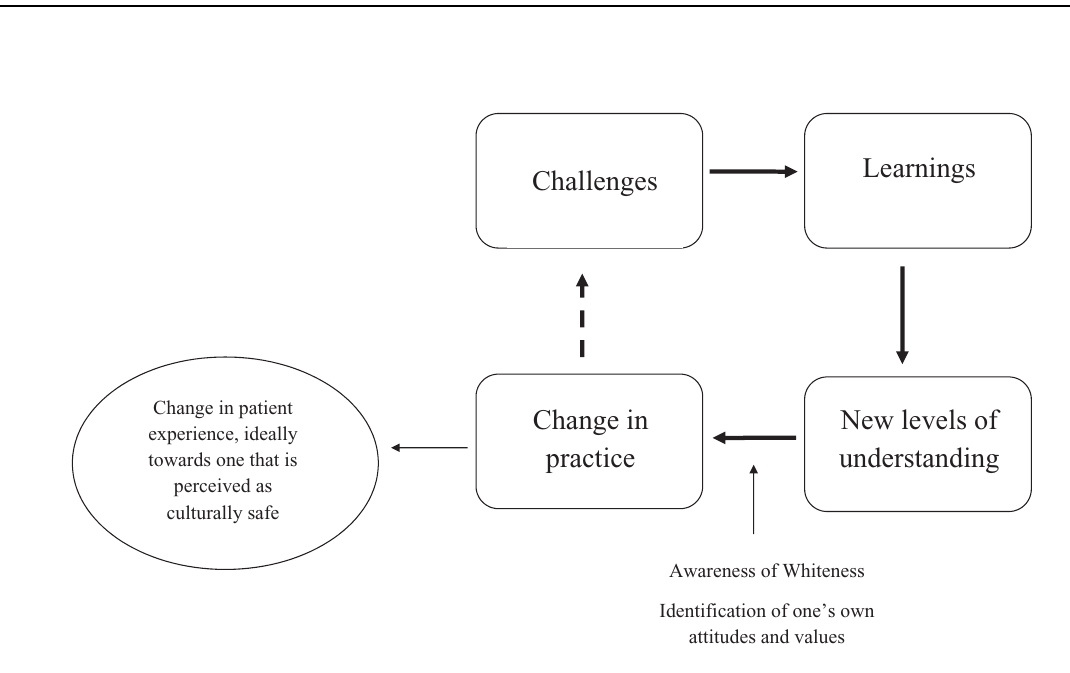
Suggested process for reflexivity for health professionals, researchers and others working in Aboriginal and Torres Strait Islander health